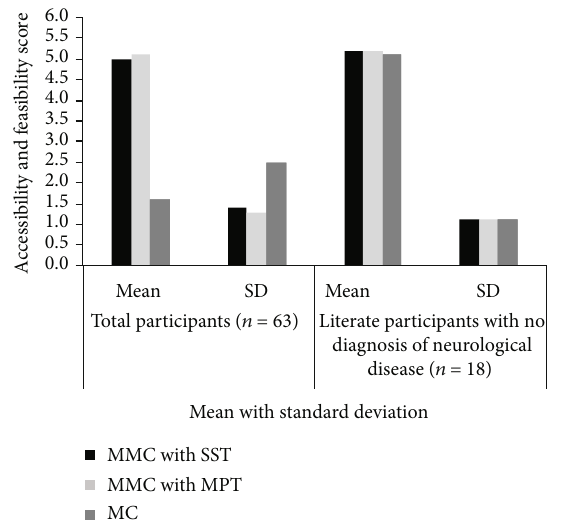
Figure 2: Accessibility and feasibility of di ff erent Mini-Cog versions. MC: Mini-Cog; MMC: modi fi ed Mini-Cog; SST: serial subtraction task; MPT: multistep performance task; SD: standard deviation; n : sample